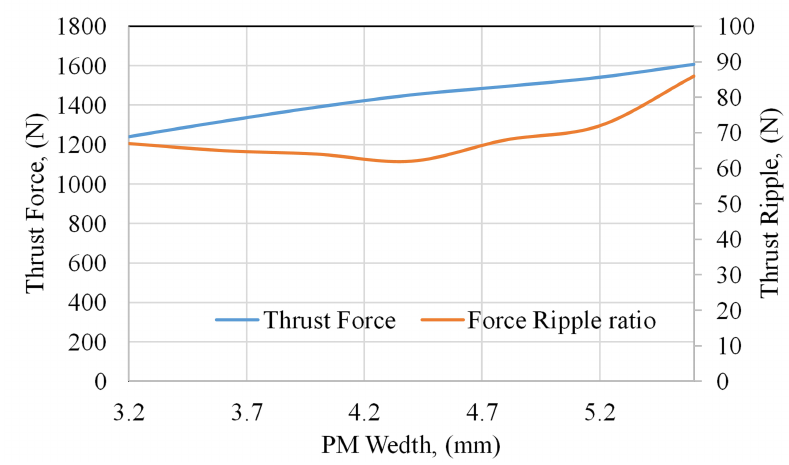
Figure 10. Variation of thrust ripples and thrust force with PM width for dual mover yokeless multi-tooth PMFSM. Table 2. Design parameters before and after optimization.